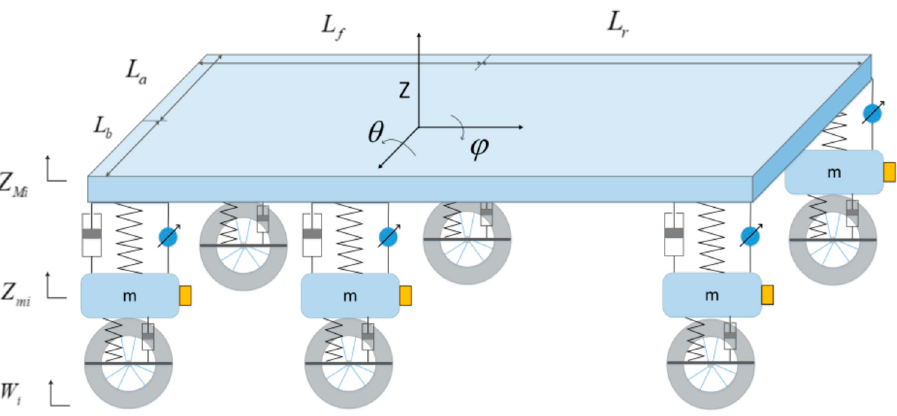
Figure 6. Autonomous vehicle model.